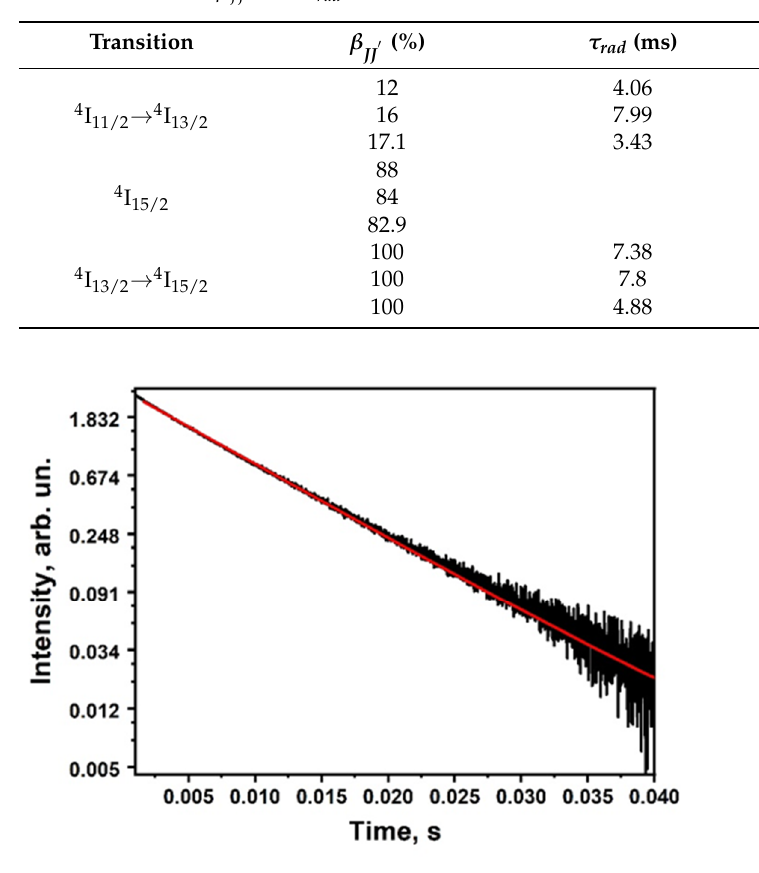
Figure 7. The luminescence kinetics near 1.6 µm. The absorption cross-section spectrum of the Er 3+ :Y 2 O 3 optical ceramics in the spectral range of 1420–1700 nm is presented in Figure 8 along with the stimulated emission cross- section spectra (SECS), calculated using the MRM (1) and FLE (2). The maximal